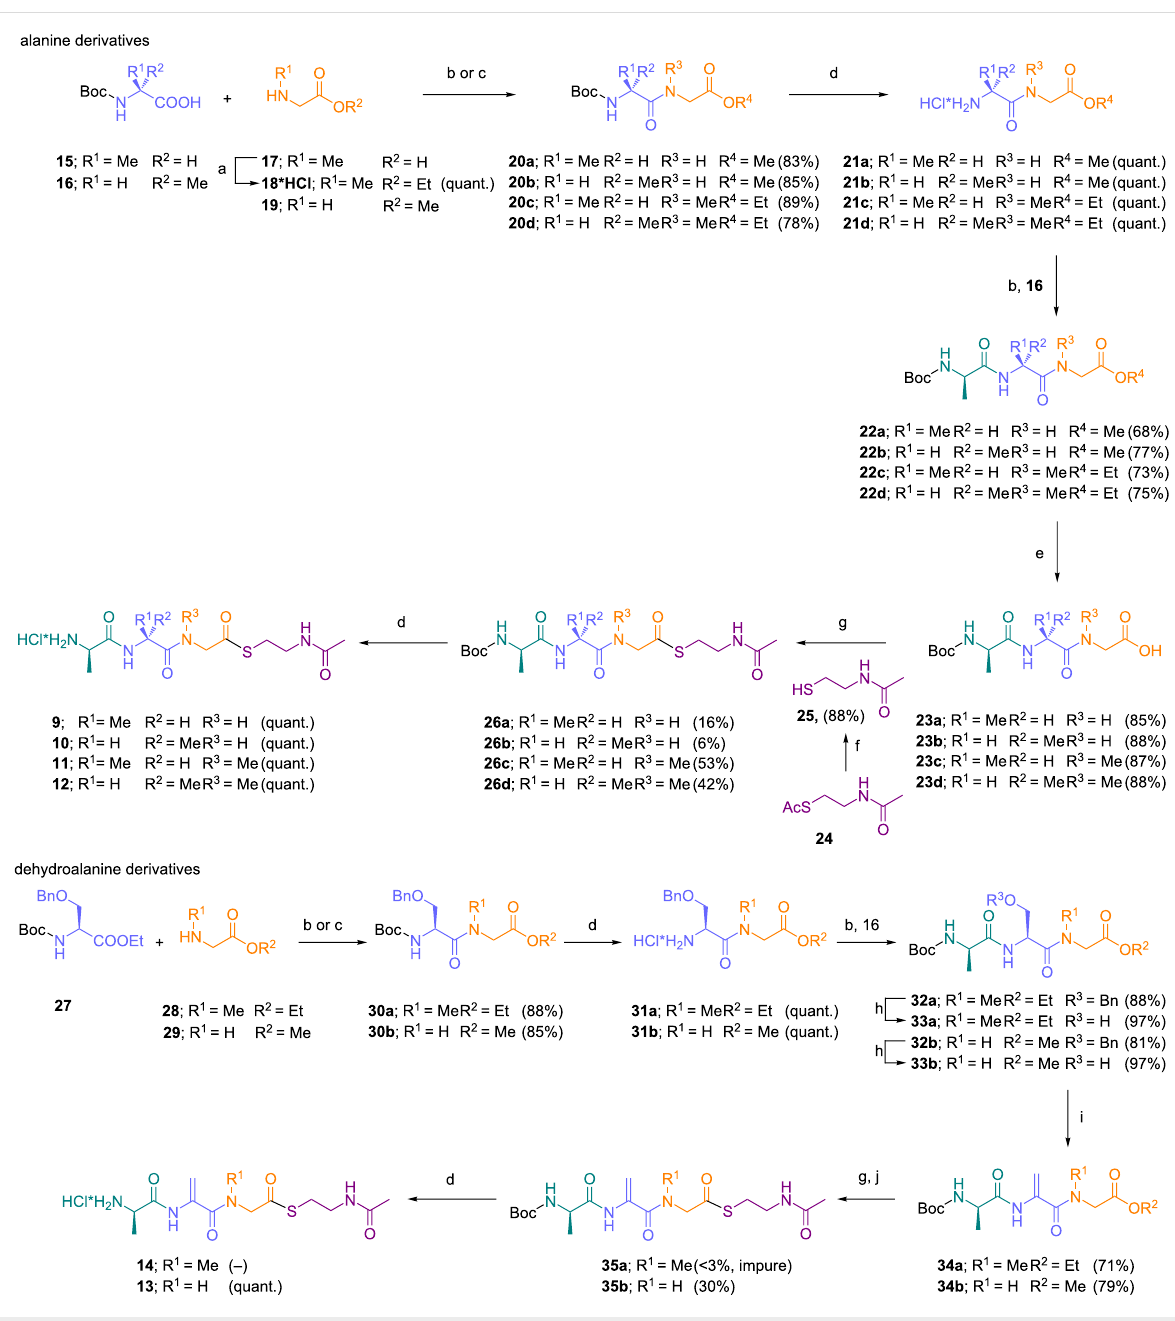
Scheme 1: Synthesis of tripeptide thioesters. Reagents and conditions: (a) SOCl 2 , EtOH, 78 °C; (b) IBCF, NMM, THF, − 20 °C (for 20a, 20b , 30a ); (c) PyBOP, DIPEA, CH 2 Cl 2 , 0 °C (for 20c , 20d , 30b ); (d) 4 M HCl/dioxane, rt; (e) NaOH, dioxane, 0 °C; (f) KOH, H 2 O, 0 °C to rt; (g) (for 26a